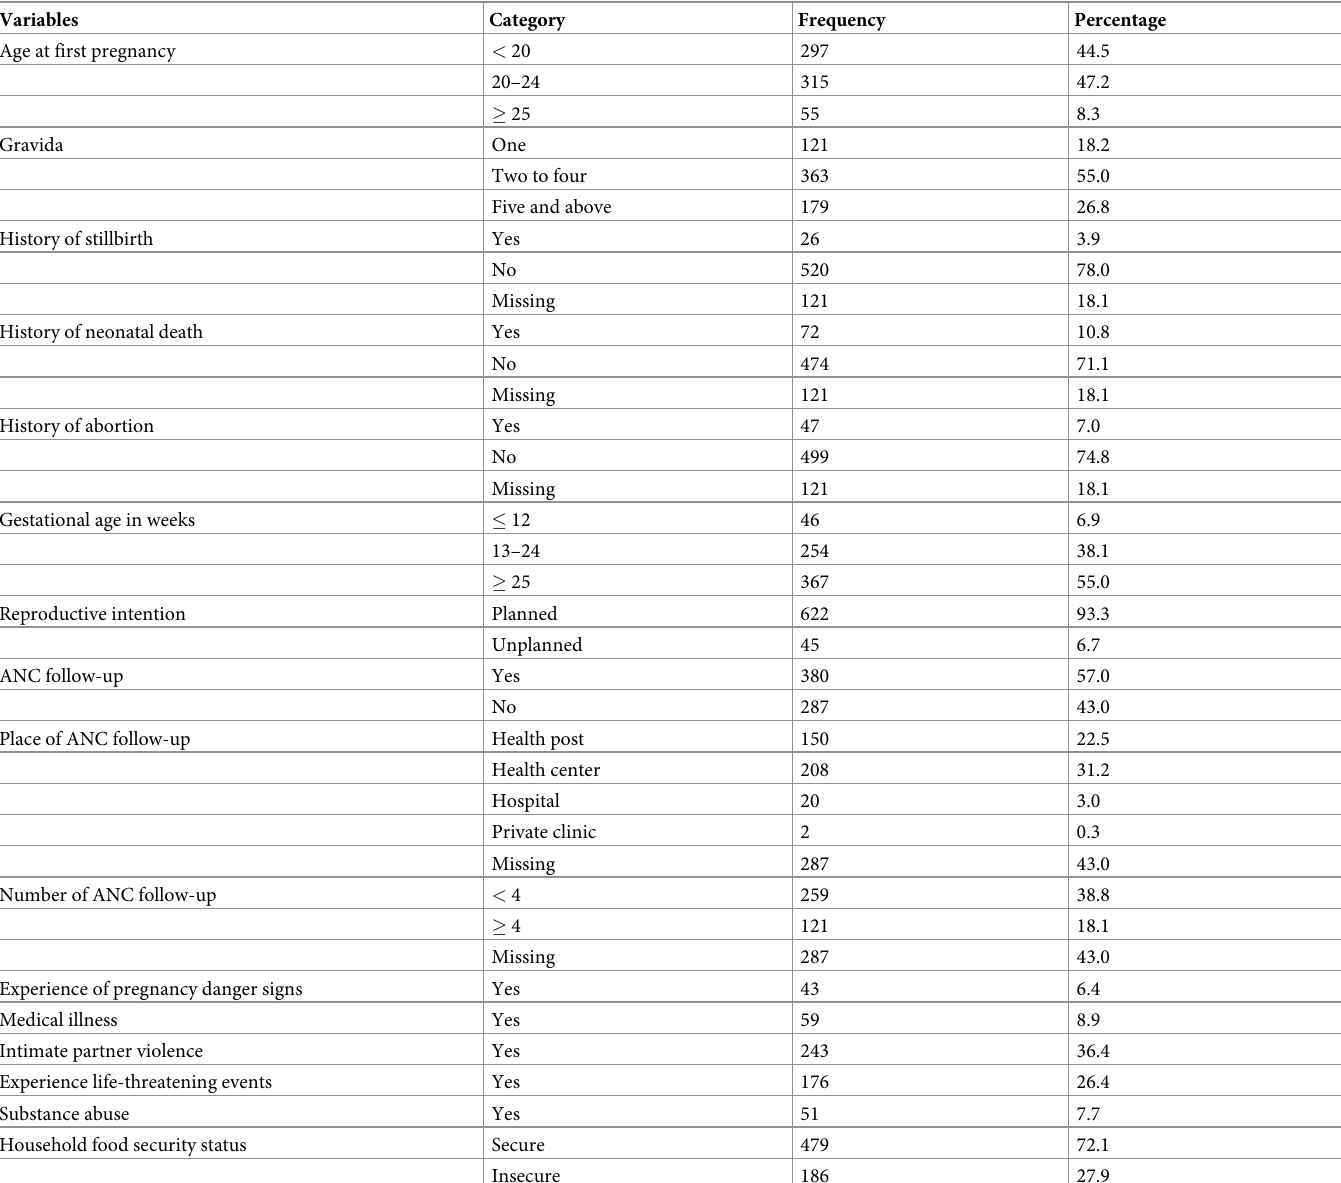
Table 2. Obstetrics characteristics of participants in Arba Minch Zuria district, Gamo zone, southern Ethiopia, 2019, (n =